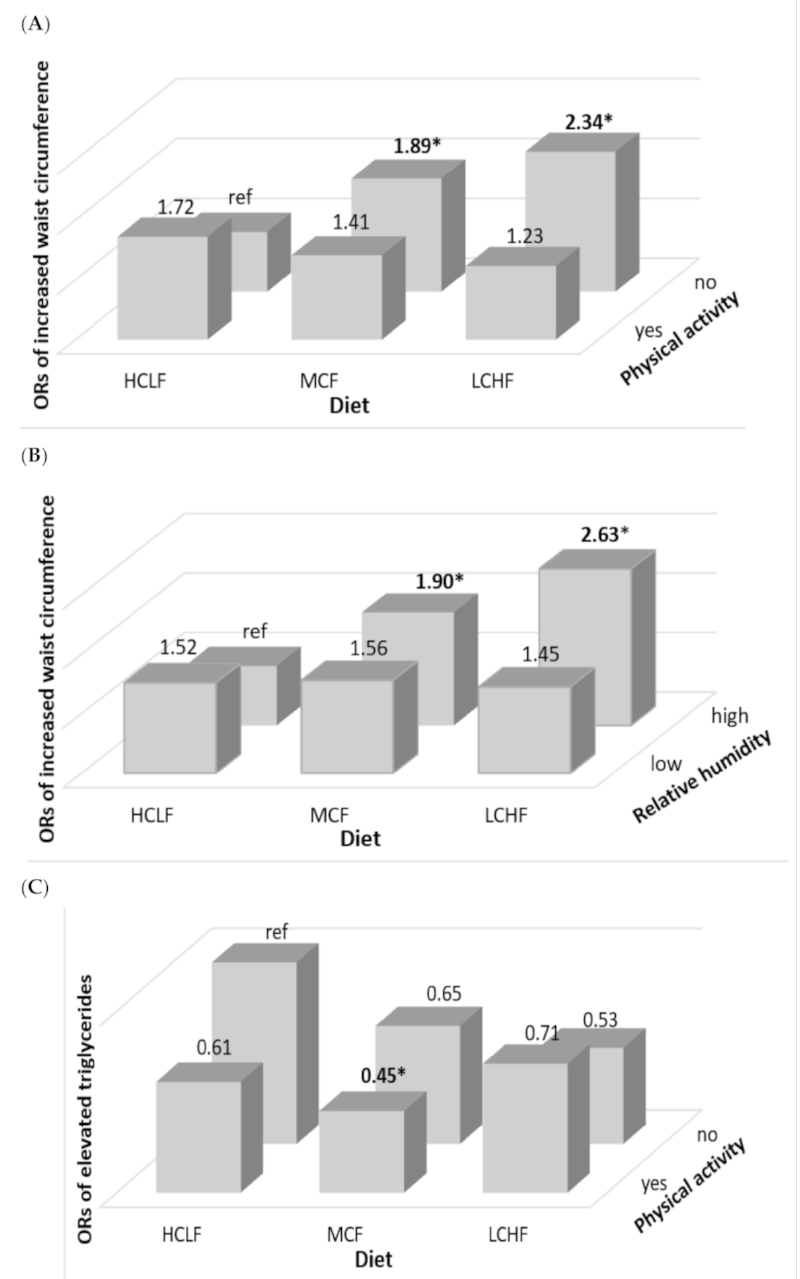
Figure 1. Adjusted odds ratios of MetS in Ecuadorian men according to diet, physical activity, and environment. ( A ) Odd ratios for increased waist circumference by the status of carbohydrate and fat intake and physical activity; ( B ) odd ratios for increased waist circumference by the status of carbohydrate and fat intake and relative humidity; and ( C ) odd ratios for elevated triglycerides by the status of carbohydrate and fat intake and physical activity. All values accounted for the complex sampling design effect of the national surveys using PROC SURVEY procedure. Ethnicity, family economic status, education level, elevation, relative humidity, BMI (except for the model of waist circumference), and total energy intake were adjusted for the multiple logistic regression. Yes or No for physical activity, and high (>80%) or low (50–80%) for relative humidity. * indicates statistical significance ( p <